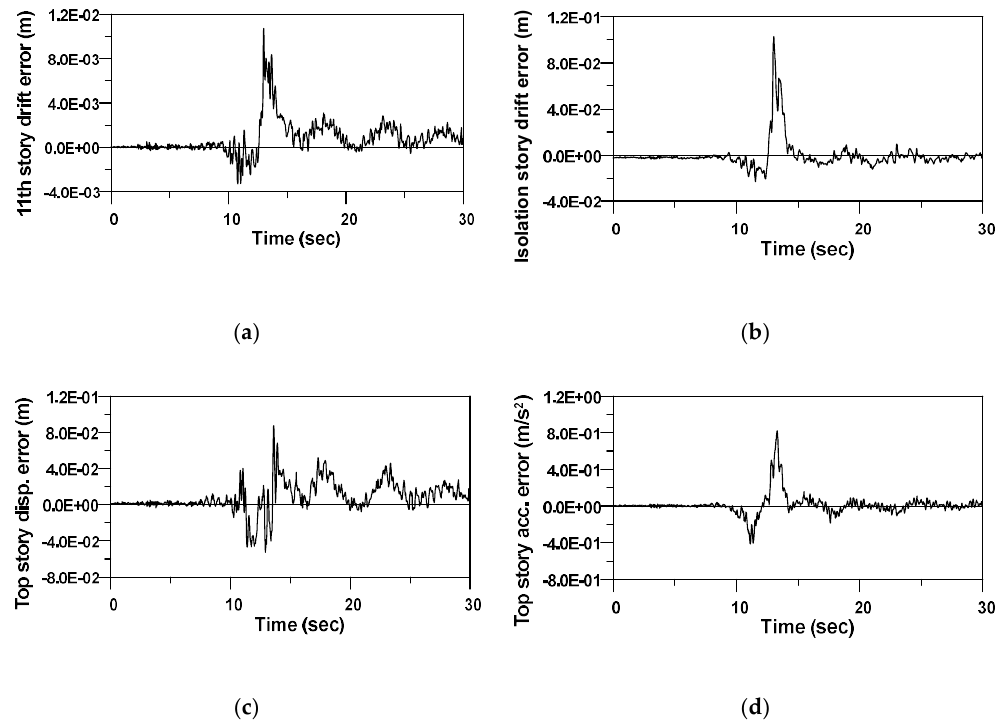
Figure 15. Response error time histories of Example 2 (EQ No. 13): ( a ) 11th story drift error time history; ( b ) Isolation story drift error time history; ( c ) Top story displacement error time history; ( d ) Top story acceleration error time history.